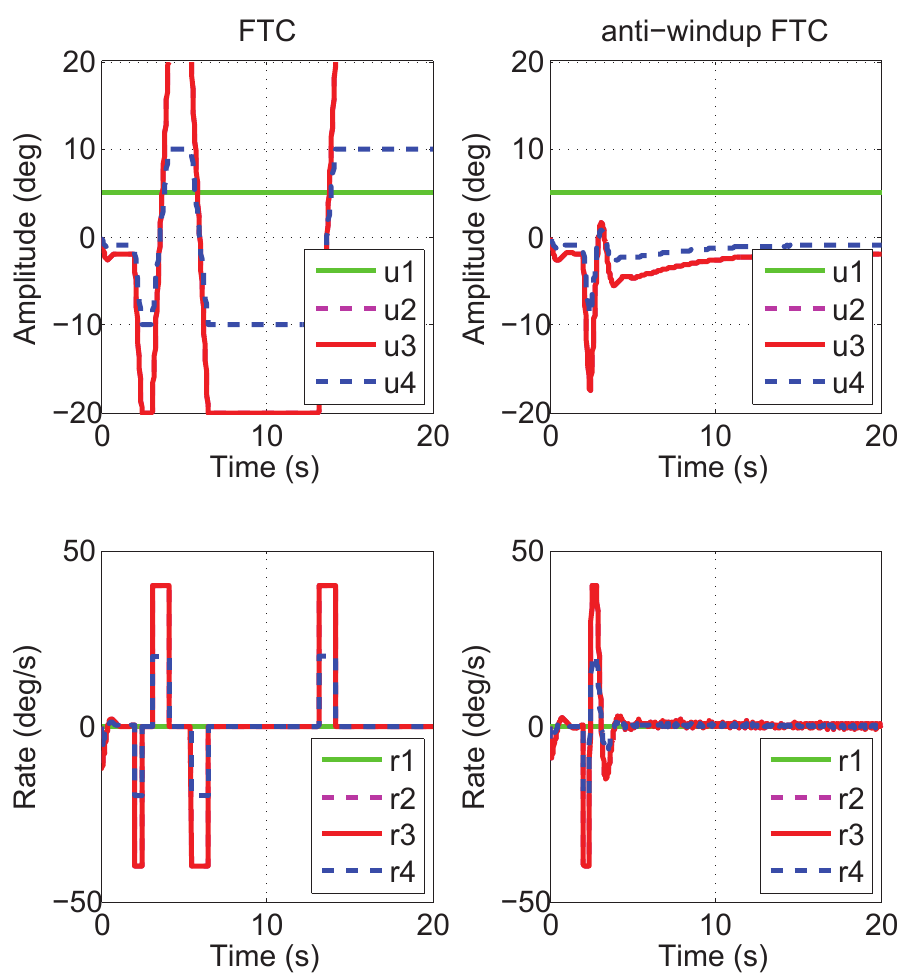
Figure 12. Actuator deflections and